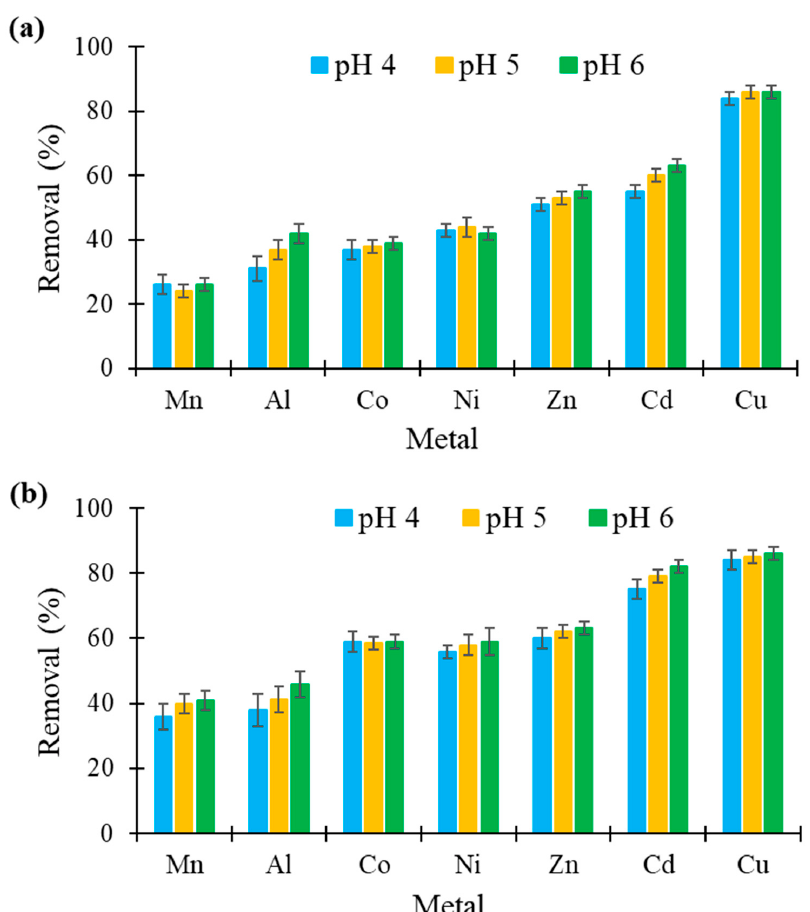
Figure 6. Influence of pH on the removal (in %) of seven metals by ( a ) hemp- and ( b ) flax-based felts from mono-contaminated solutions at an initial concentration of 25 mg/L (other conditions: 1 g of felt in 100 mL of solution; contact time, 60 min; agitation speed, 250 rpm; temperature, 22 ± 1°C; n = 3).